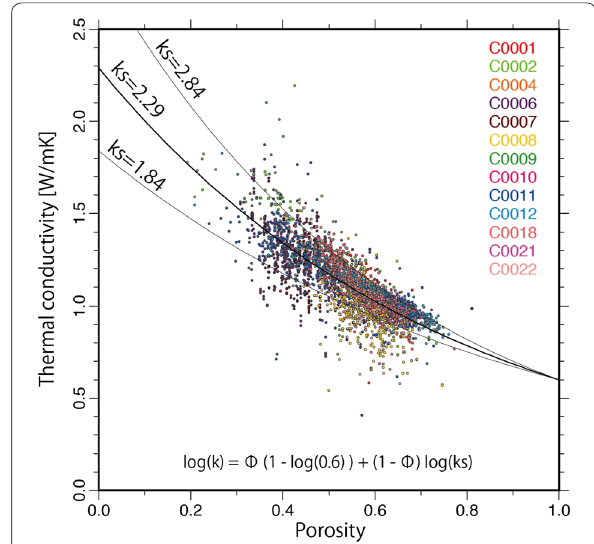
Fig. 7 Correlation between XCT-derived porosity and thermal